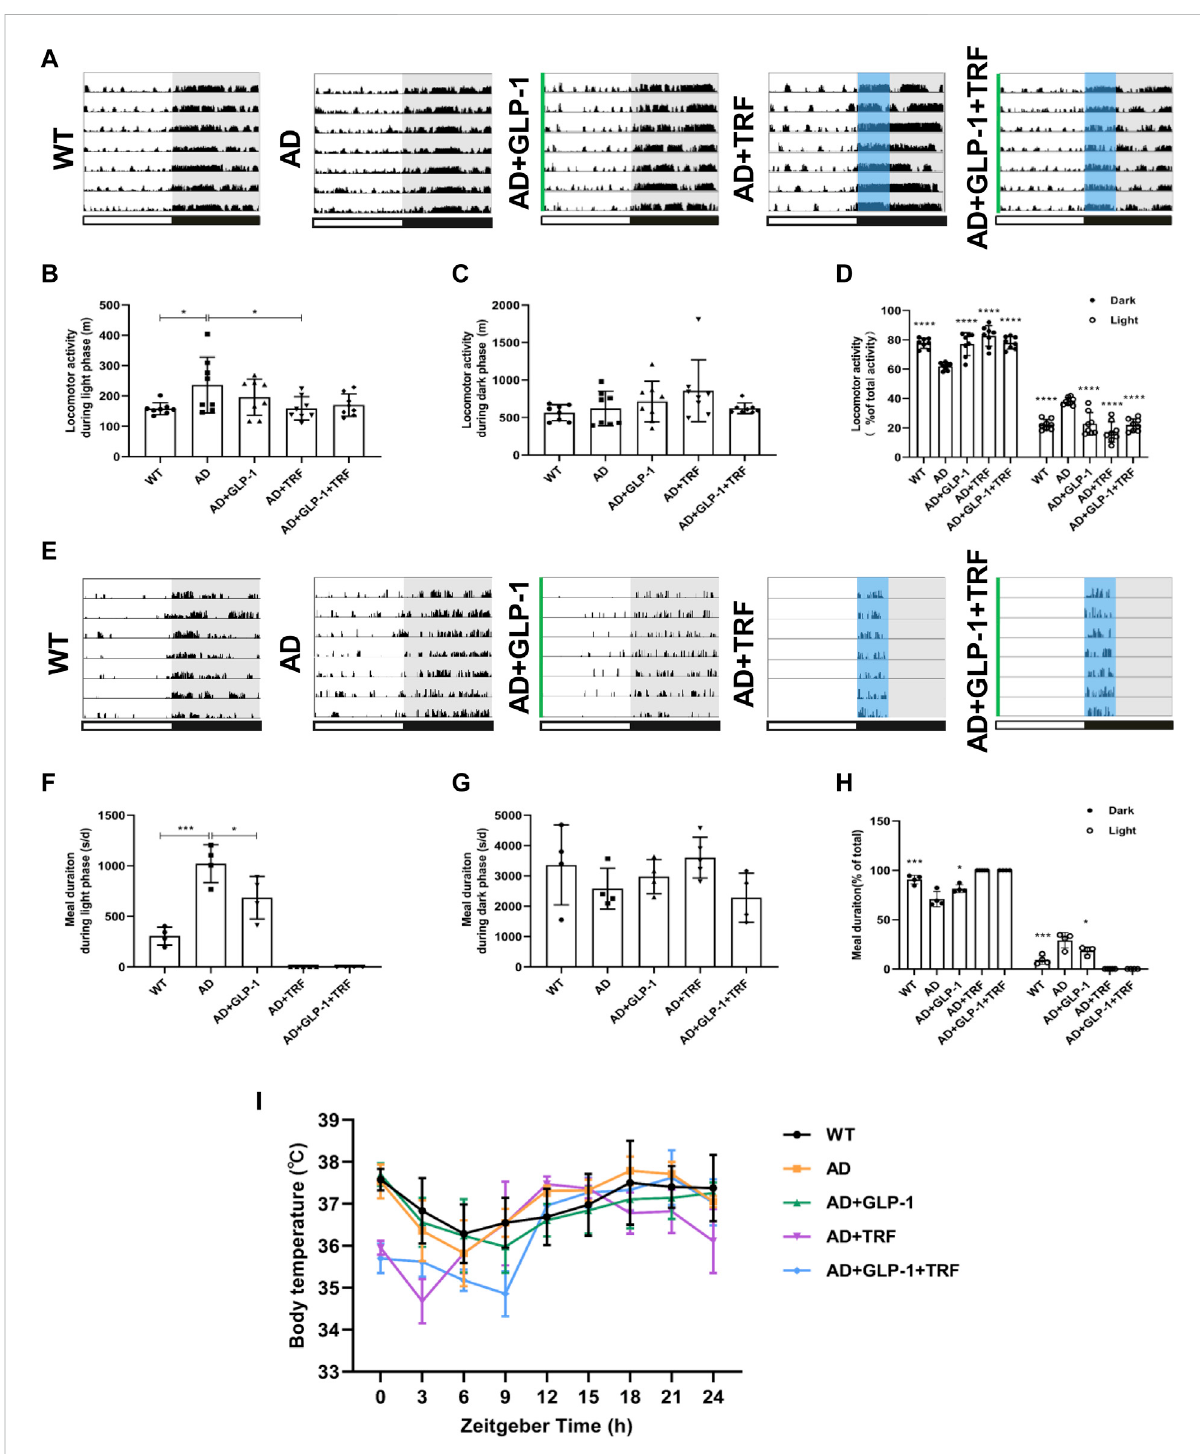
FIGURE 2 Effect of GLP-1 and TRF on circadian rhythm disorder in mice models of Alzheimer ’ s disease. (A) Representative locomotor activity records of each group. The green line represents the time of intraperitoneal injection of GLP-1 to this group of mice. The blue area delineates 4-h of feeding time. (B) Activity during the light phase (m). n = 7 per group, * p < 0.05 vs. AD group using One-Way ANOVA followed by Dunnett ’ s test. (C) Activity during the dark phase (m). (D) Ratio of the activity in the dark and light/total activity in each group. n = 7 per group, **** p < 0.0001 vs. AD mice using two-way ANOVA followed by Dunnett ’ s test. (E) Representative meal duration records of each group. (F) Meal duration during the light phase (s). n ≥ 4pergroup,* p < 0.05,*** p < 0.0001vs.ADgroupusingOne-WayANOVAfollowedbyDunnett ’ stest. (G) Mealdurationduringthedarkphase (s). n ≥ 4 pergroup. (H) Ratio of meal duration inthe dark and light/total meal duration (24 h)in eachgroup. n ≥ 4 pergroup, * p < 0.05, *** p < 0.0001 vs. AD mice using Two-Way ANOVA followed by Dunnett ’ s test. (I) Body temperature was measured every 3 h for 24 h